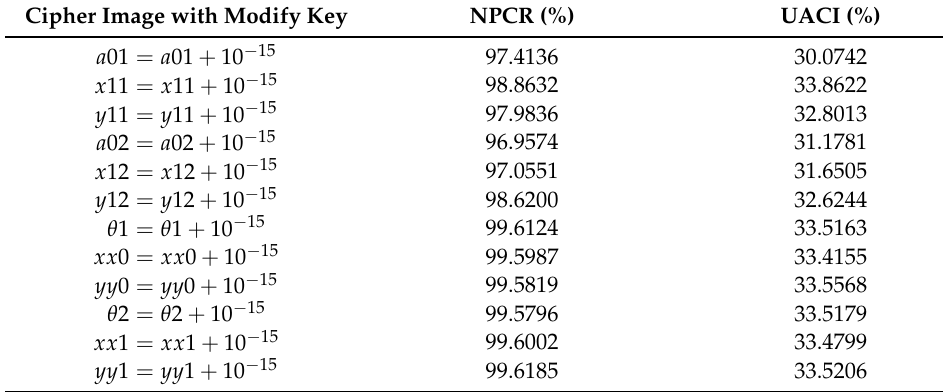
Figure 9. Comparison from encrypted images through tiny modified keys. Table 6. Quantitative analysis of key